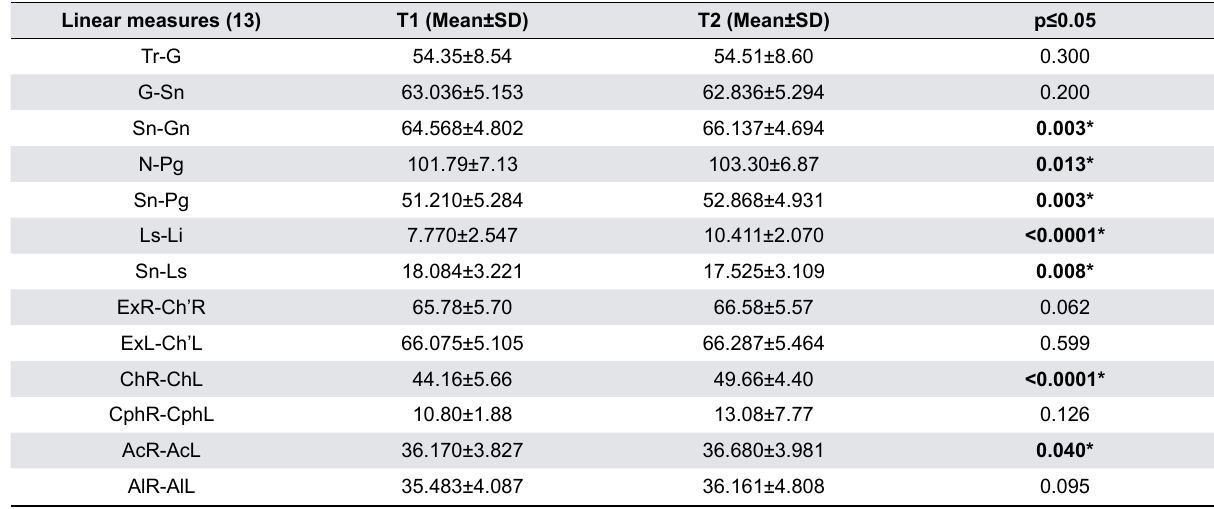
Paired t-test, * Statistically significant difference; SD: standard